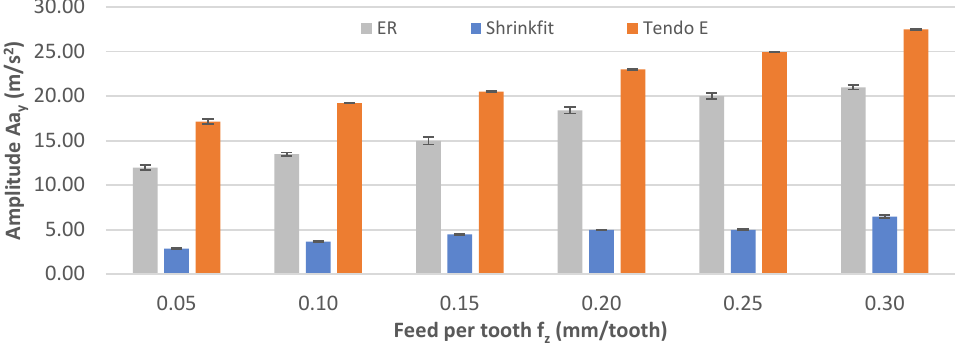
Figure 16. Impact of feed per tooth f z on the vibration acceleration amplitude Aa y (v c = 800 m/min, a p = 6 mm).